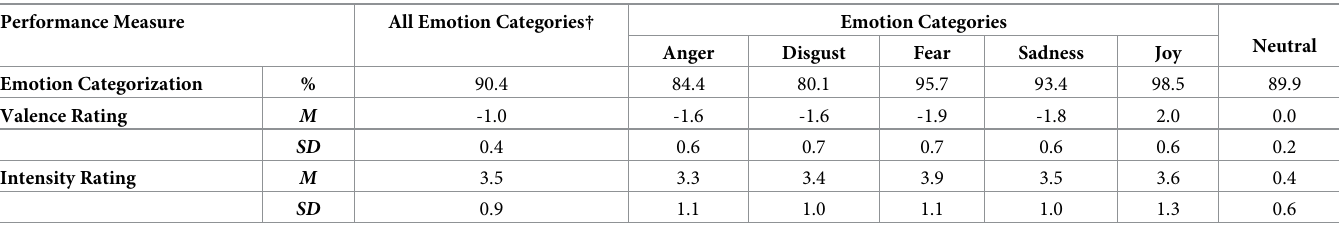
Table 2. Task performance across all participants ( N =